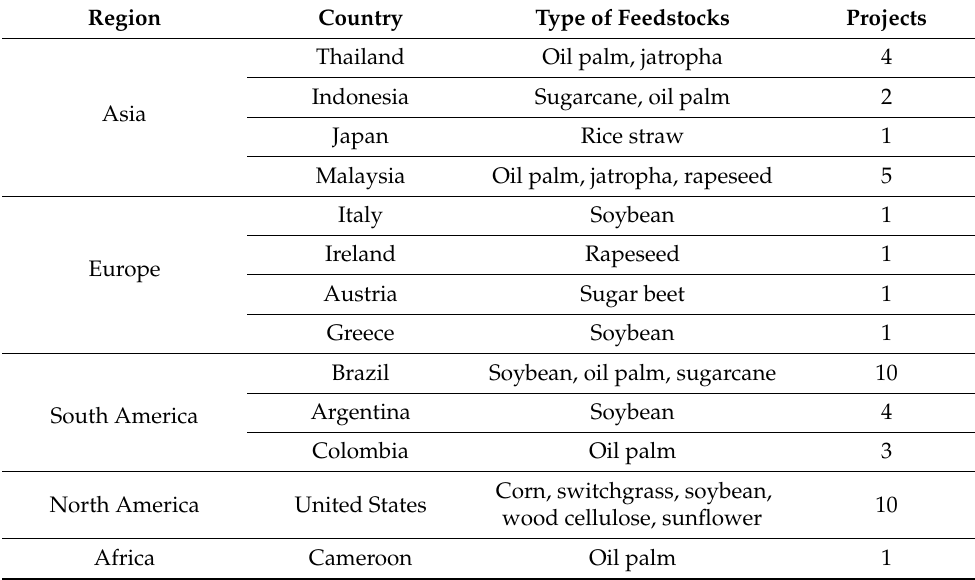
Table 1. Geographical distribution and type of feedstocks reviewed in this study.